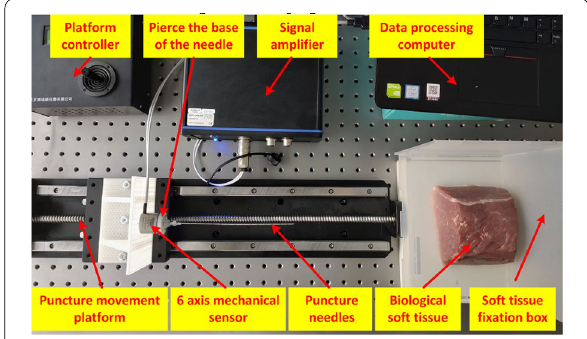
Figure 8 Top view of the extracorporeal puncture experimental